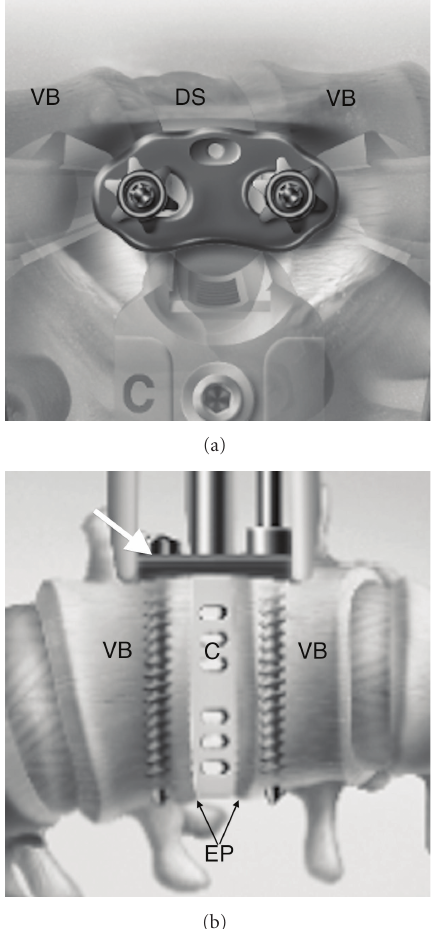
Figure 1: XLP lateral plate. (a) Lateral view. Notice the plate spans across the disc space (DS) and is secured down to the vertebral bodies (VB) with lock nuts. (b) AP view. Lateral plate (white arrow) is seated on two bicortical screws, which are parallel to the adjacent endplates (EP). A cage (C) is depicted in the disc space. (Images used with permission of NuVasive, Inc., San Diego, CA,